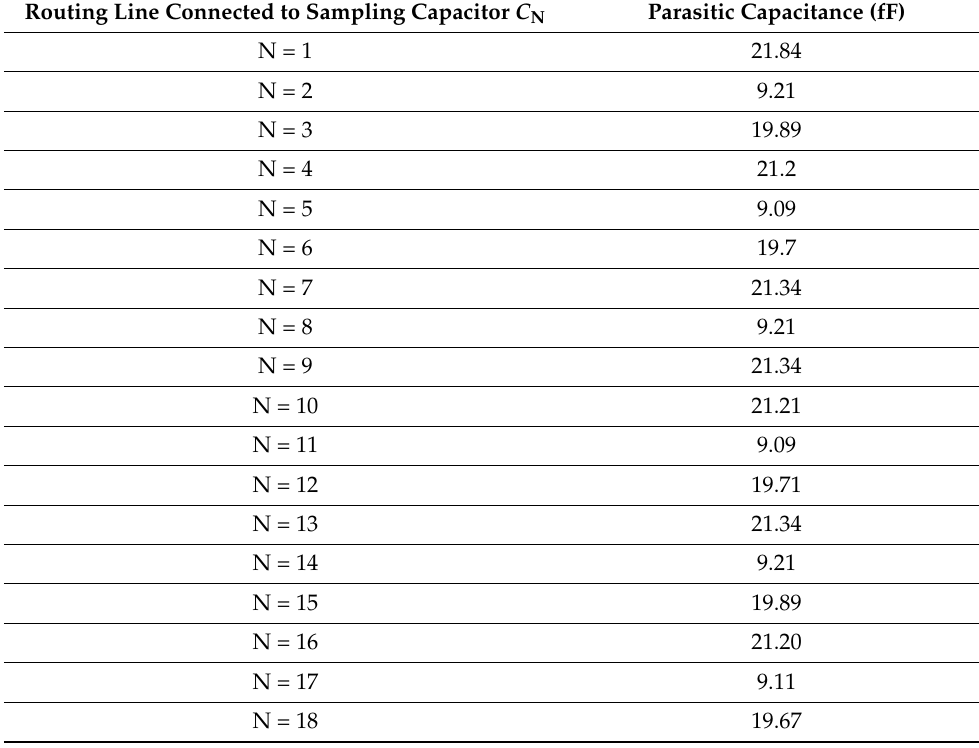
Table 4. Parasitic capacitance of routing lines connected to sampling capacitors in the positive path. Routing Line Connected to Sampling Capacitor C N